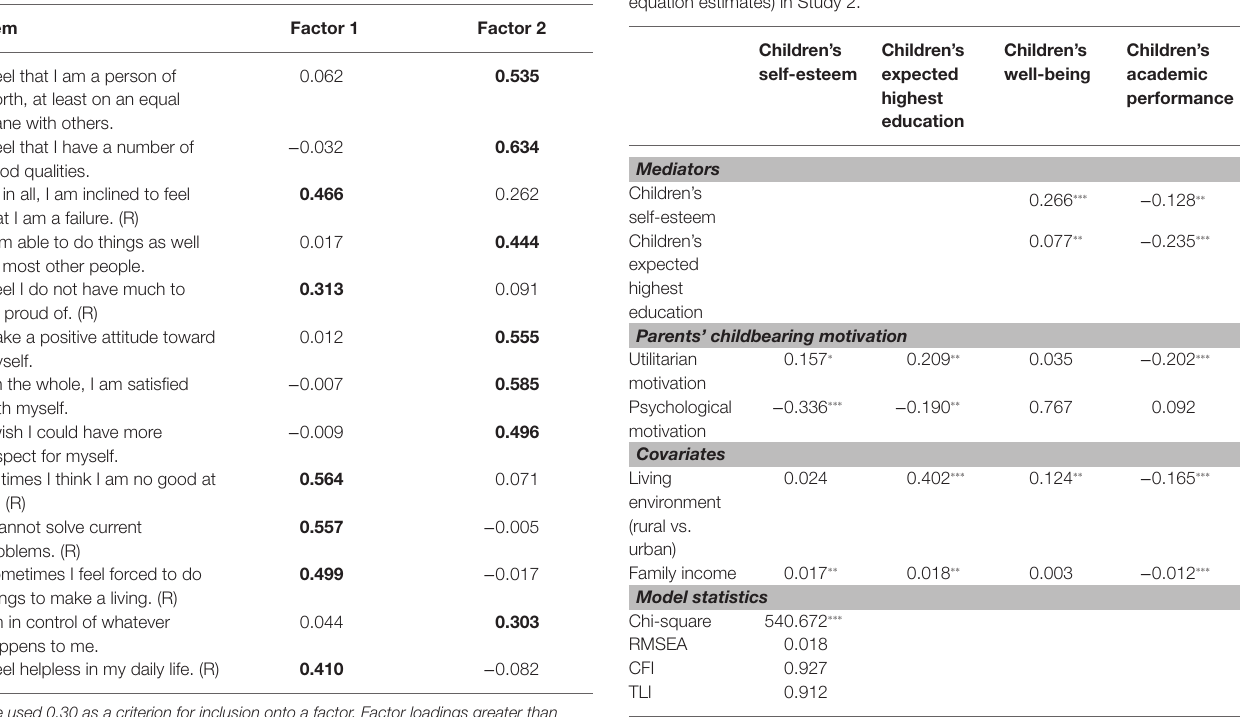
TABLE 4 | Factor loadings for the 13 items of self-esteem in Study